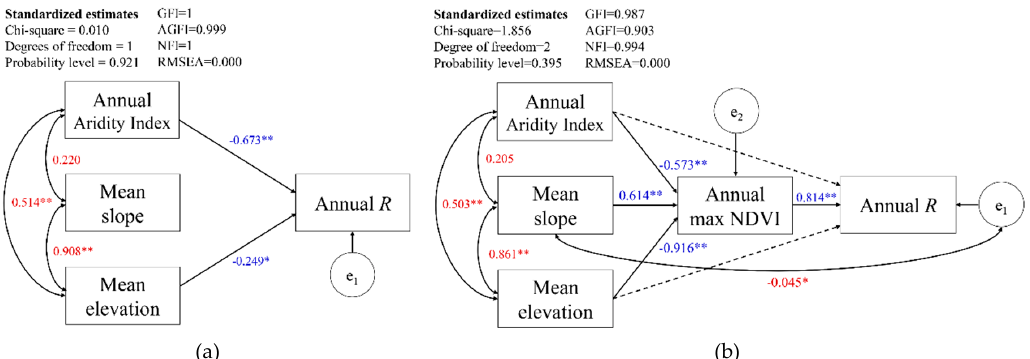
Figure 7. The structured equation model (( a ) detection of climatic and topographic effects; ( b ) detection of vegetation’s function). Note: e 1 and e 2 represent the measurement error of NDVI and R generation, respectively. ** Correlation is signigicant at the 0.001 level (two-tailed). * Correlation is siginificant at the 0.05 level (two-tailed). Numbers in red indicate the correlation coefficient; numbers in blue represent standized regression weights. Dotted lines represent a nonsignificant path of a direct effect.